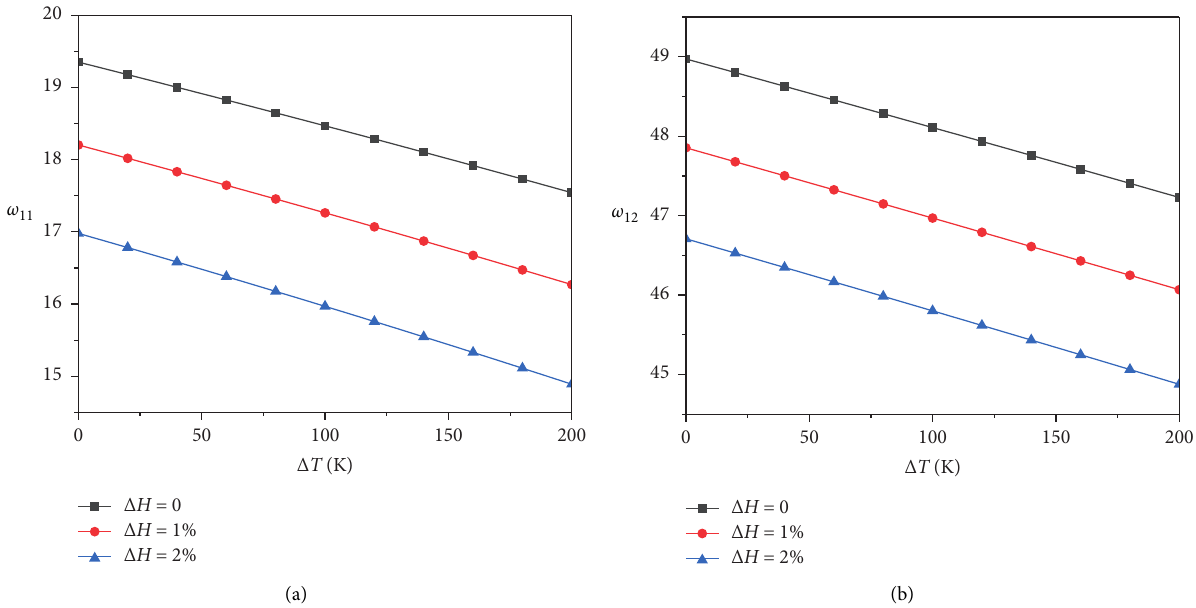
Figure 4: Variation of the vibration frequency with respect to temperature changing under different moisture concentrations. (a) The first- order vibration frequency. (b) The second-order vibration frequency.